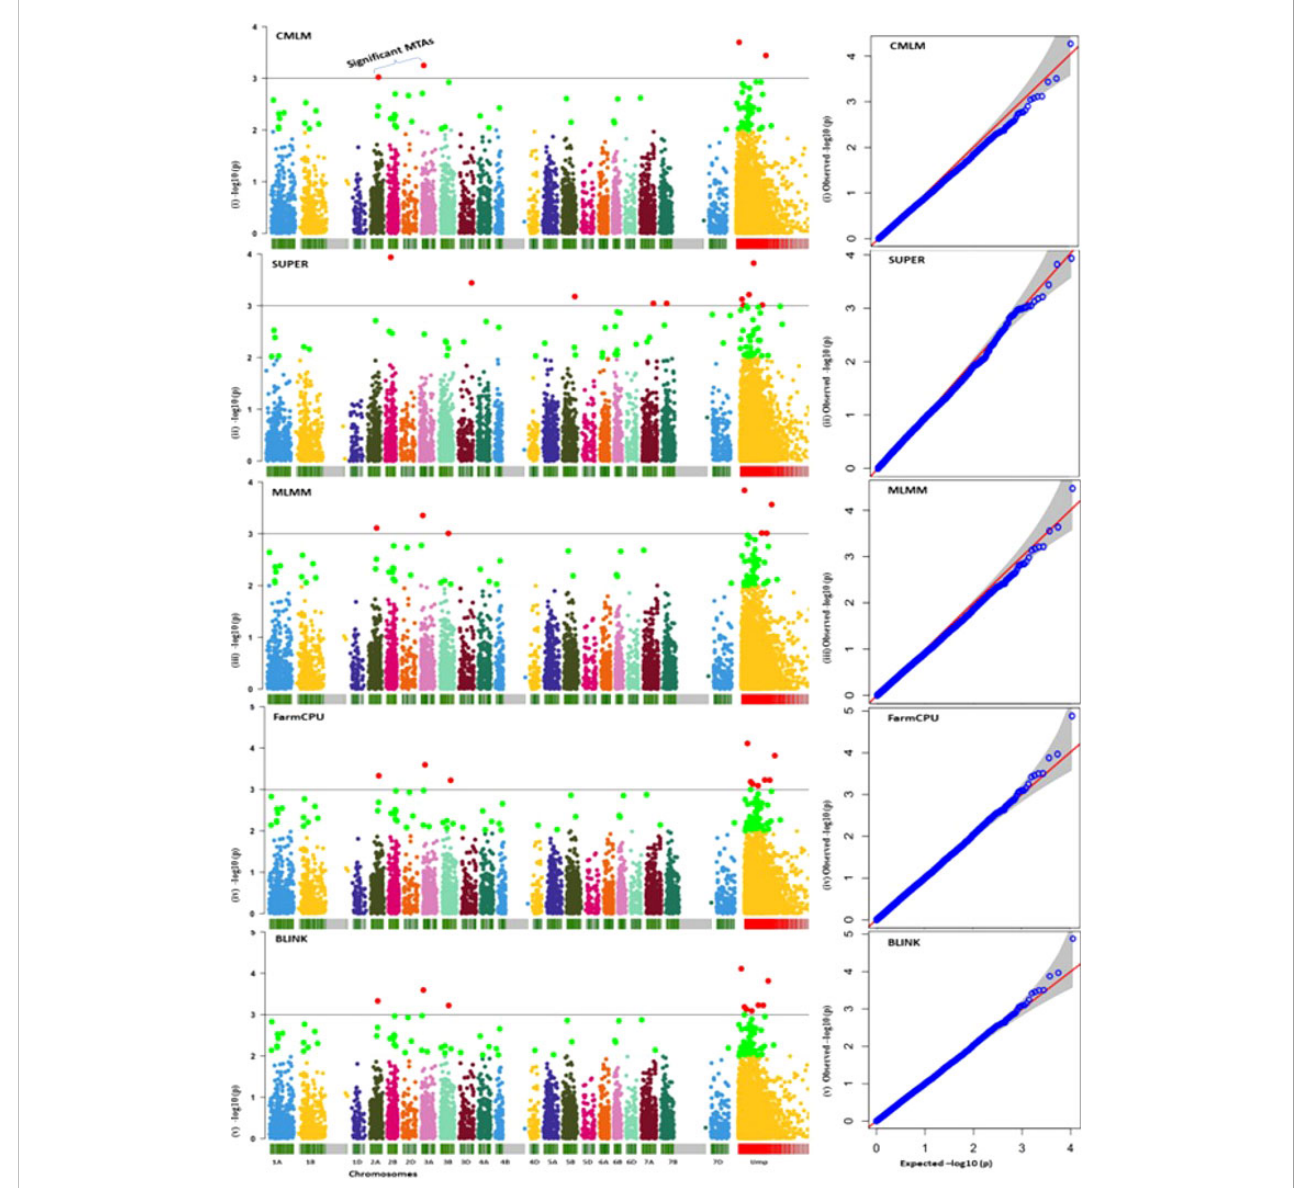
FIGURE 4 A set of representative Manhattan plots (left panel) and Q – Q plots (right panel; expected values shown as red line assuming no association) for fi ve models (for only BLUP values for AUDPC); red dots above the horizontal line depict signi fi cant